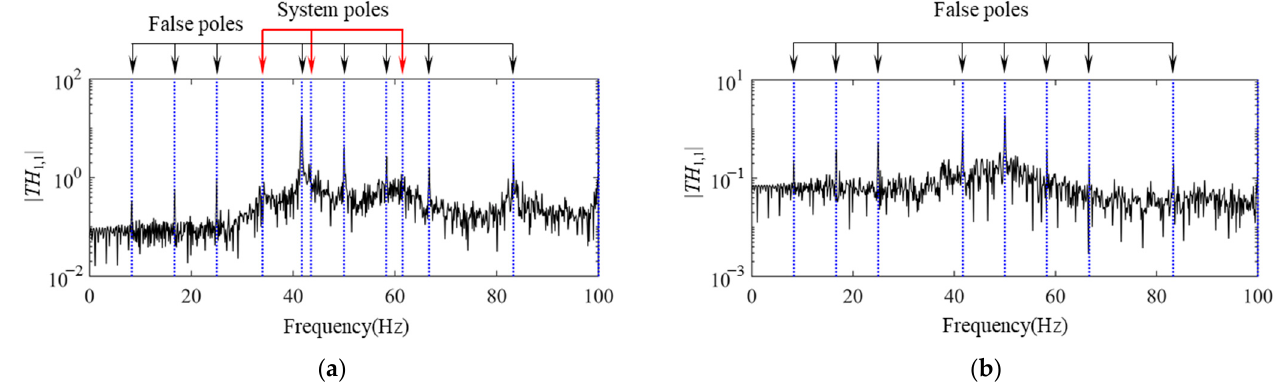
Figure 16. System pole recognition based on the virtual frequency response function. ( a ) Conventional TRF; ( b ) delayed TRF.